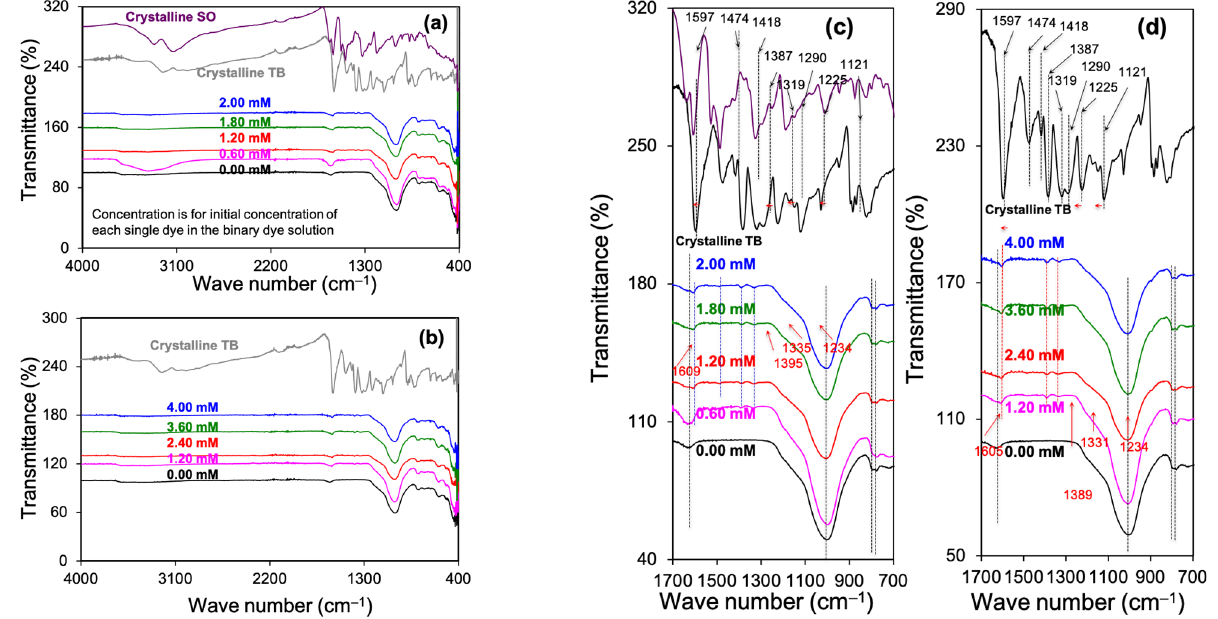
Figure 6. FTIR spectra of ZEO after dye sorption from binary ( a ) and single TB ( b ) solutions of different initial concentrations and their enlargement ( c , d ) in the wave numbers of 700–1700 cm − 1 .